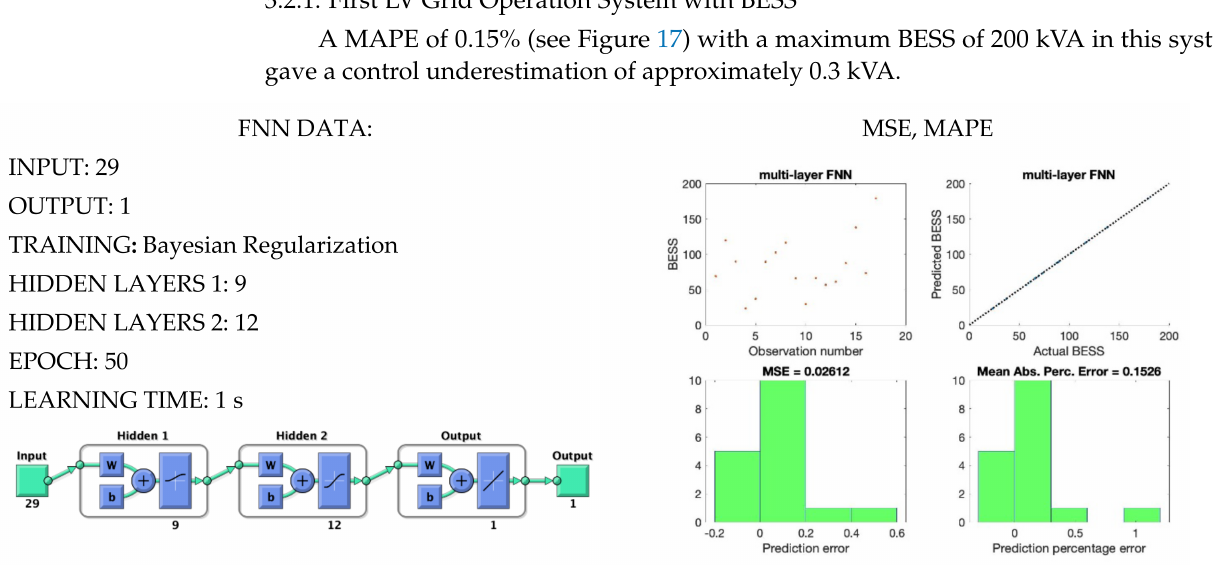
Figure 17. FNN machine learning results for BESS.